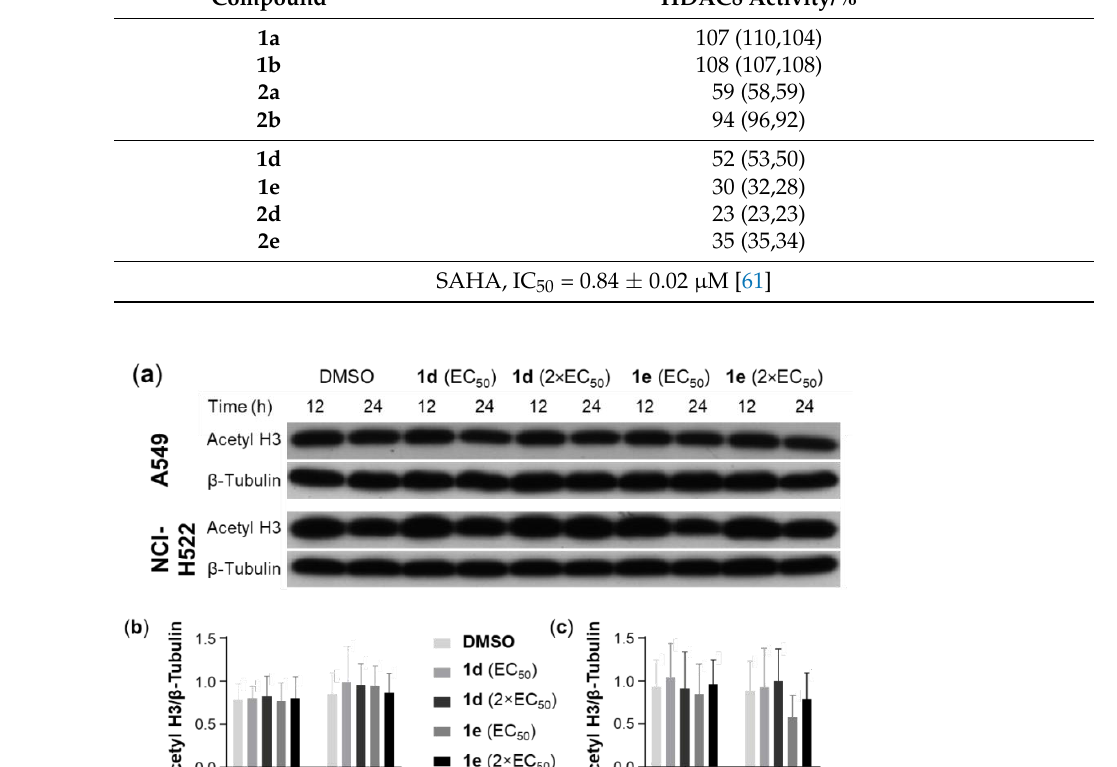
Table 3. Mean values for residual activity of HDAC8 after treatment with 1a, 1b, 1d, 1e, 2a, 2b, 2d , and 2e at 10 μM. The numbers in brackets are the two recorded data points ( n = 2). Compound HDAC8 Activity/%